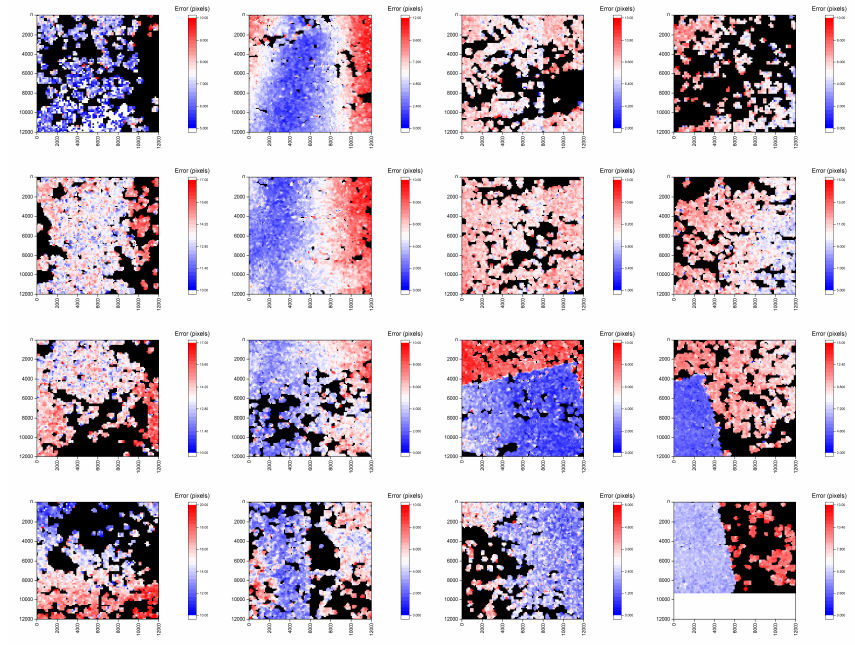
Figure 2 Original error distribution Table 1 Statistics of the single-model correction accuracy (unit: pixels)